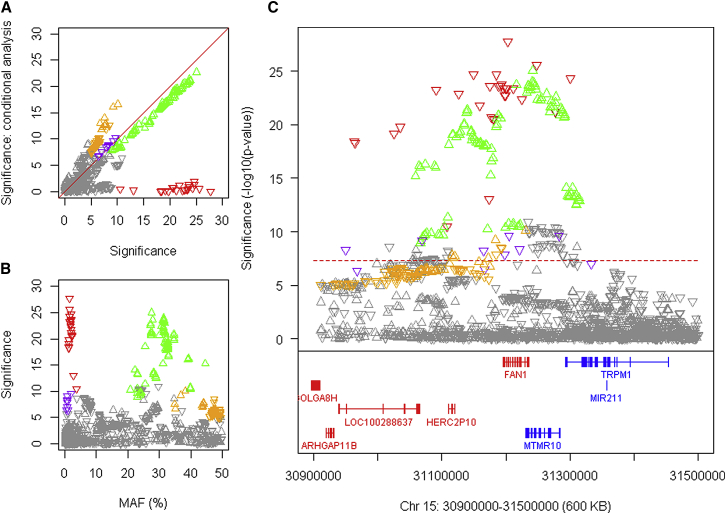
Four HD Onset Modification Signals at FAN1(A) SNP significance (–log10(p value) in continuous analysis conditioned on the top 15AM1 (red) SNP compared to GWA12345 significance reveals independent modifier haplotypes: 15AM2 (green), 15AM3 (purple), and 15AM4 (gold). Because SNPs tagging 15AM4 have alleles of close to equal frequency, the direction of the arrow varies depending on whether the minor or major allele is on the 15AM4 haplotype.(B) SNP significance compared to MAF.(C) SNP significance relative to genes in the region.See also Figure S6.